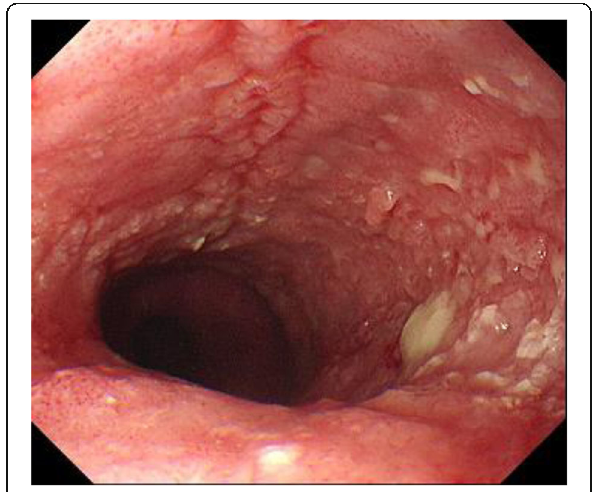
Fig. 1 Preoperative upper gastrointestinal endoscopy